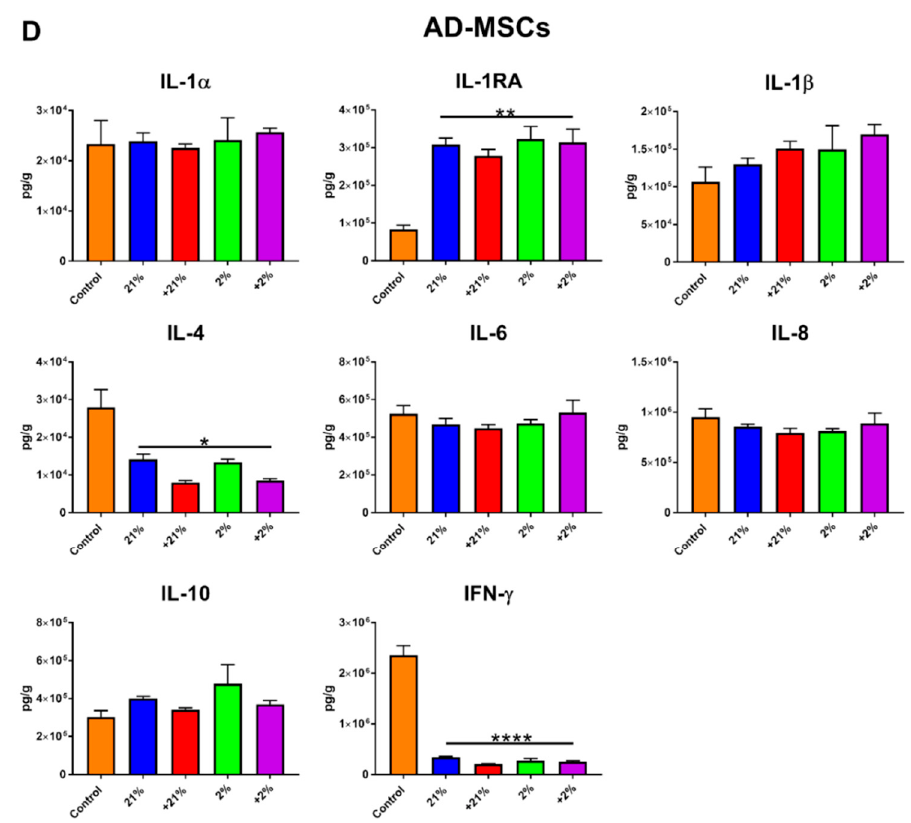
Figure 6. Immunomodulatory function of preconditioned MSCs demonstrated via an MLR assay. ( A ) Preconditioning significantly augmented the immunosuppressive function of BM-MSCs, with Cytomix-treated cells performing best. ( B ) Similar to that of their BM counterparts, immunosuppressive function of AD-MSC was augmented by all preconditioning treatments; however, compared to other groups, the normoxia-treated cells were significantly more potent. ( C ) BM-MSC co-cultures resulted in increased levels of IL-1RA and IL-1 β , while the secretion of the pro-inflammatory cytokines IL-6, IL-8, and IFN- γ was inhibited. ( D ) AD-MSC co-cultures resulted in increased levels of IL-1RA, while IL-4 and IFN- γ secretion was suppressed. * p < 0.05, ** p < 0.01, *** p < 0.001, **** p < 0.0001.